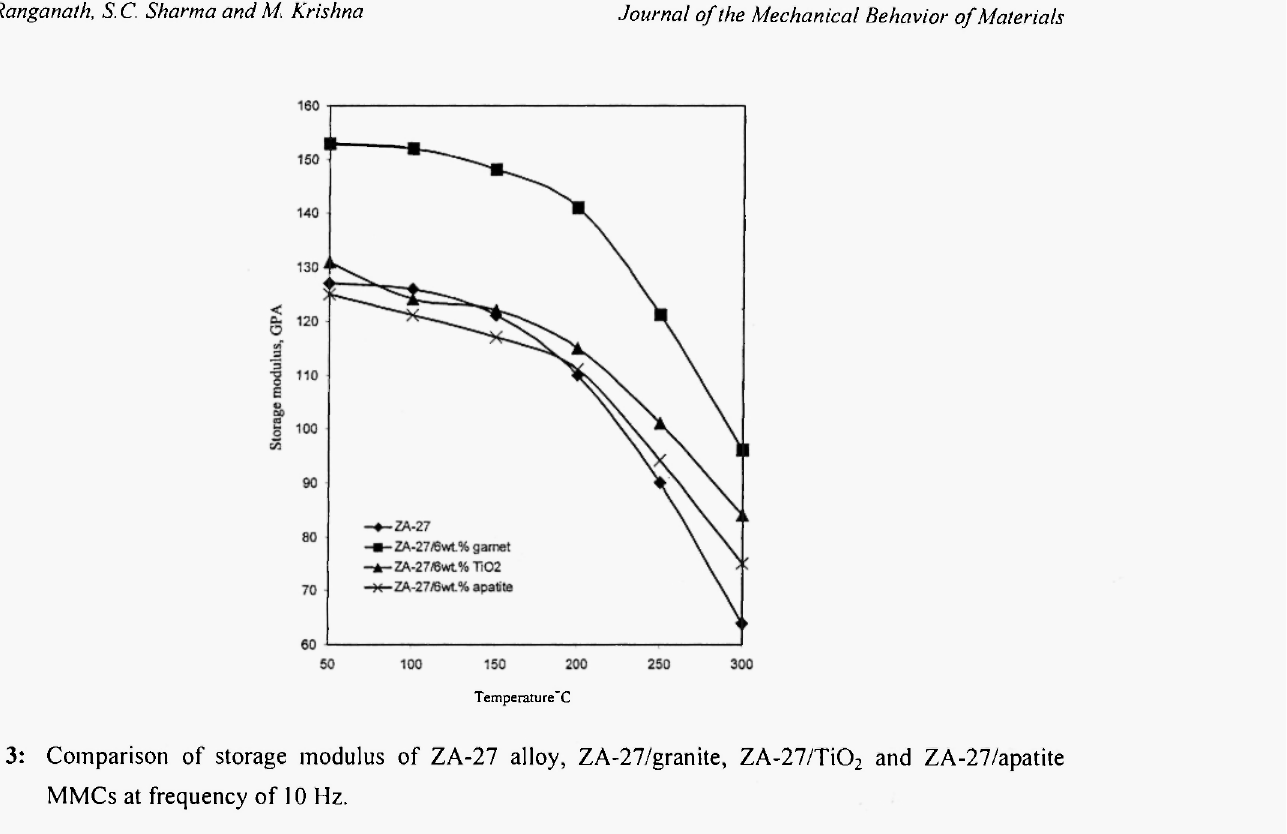
Fig. 3: Comparison of storage modulus of ZA-27 alloy, ZA-27/granite, ZA-27/Ti0 2 and ZA-27/apatite MMCs at frequency of 10 Hz.